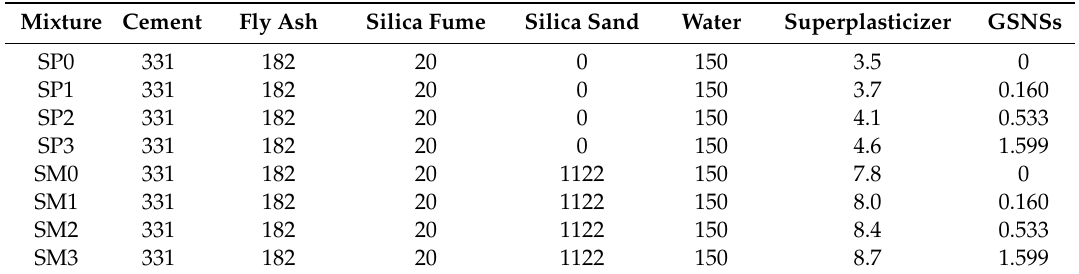
Table 2. The mix proportions of siliceous sacrificial cement paste and mortar